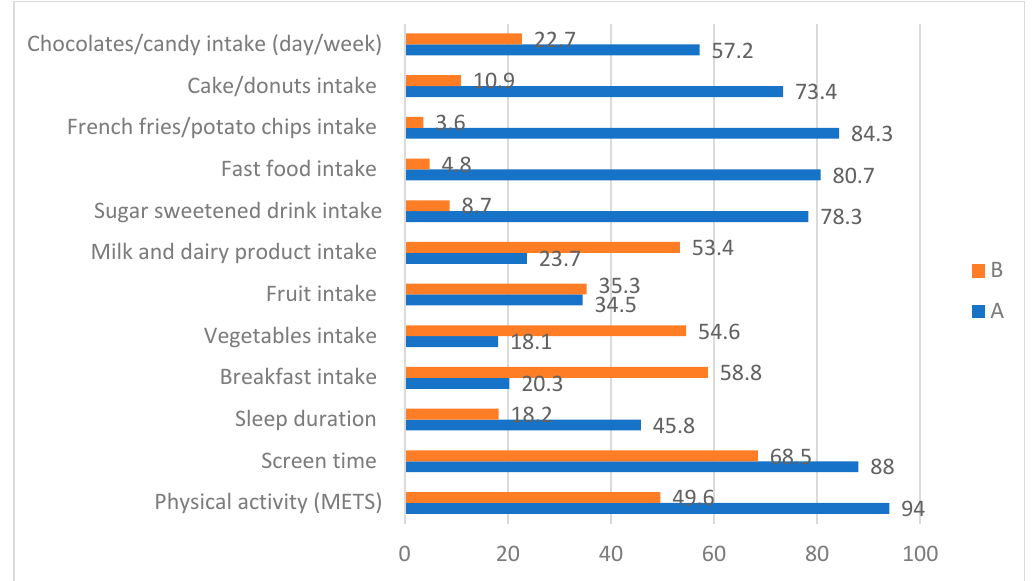
Figure 1. Proportion (%) of selected lifestyle variables at or above certain cut-off scores in female participants.